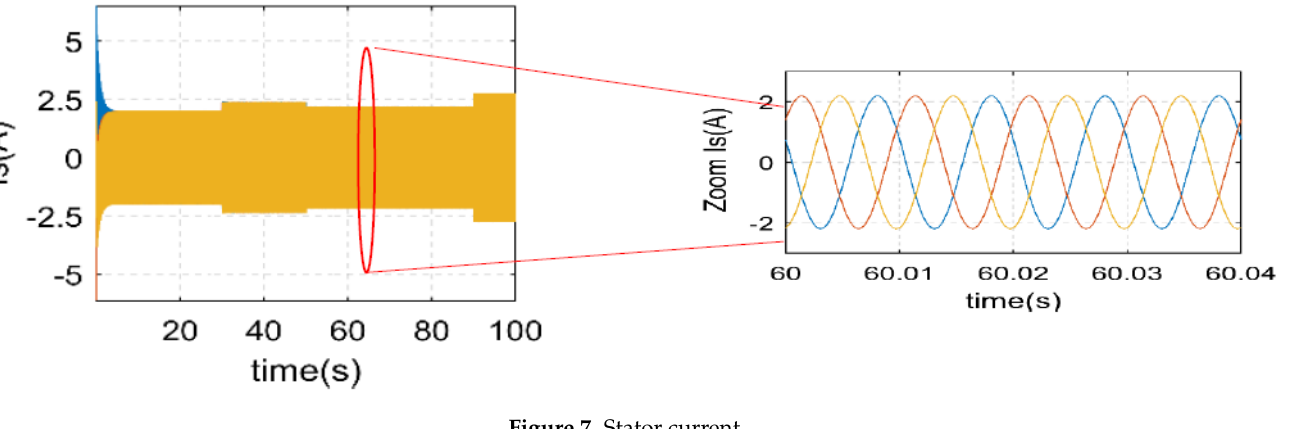
Figure 7. Stator current.